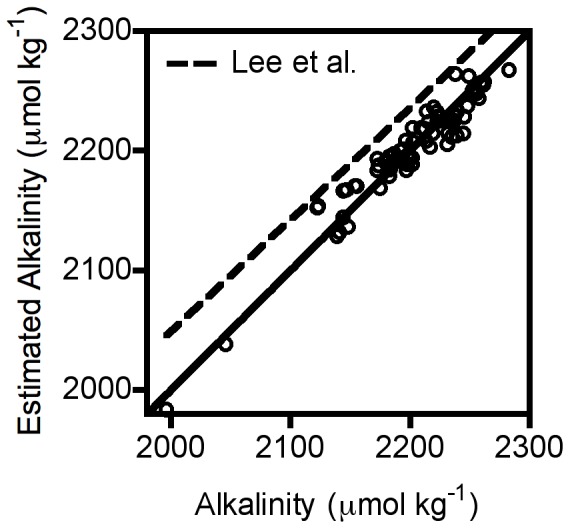
Relationship between measured alkalinity of water sample and estimated alkalinity based on temperature and salinity measurements made by an in situ probe as the water sample was collected.Dashed line: best fit line of alkalinity estimates derived from empirical relationship for the North Pacific reported in [24] and used previously in [2]. Open circles: estimated alkalinity based on custom regression between measured alkalinity and measured salinity and temperature for our site. Solid line: measured alkalinity = estimated alkalinity.